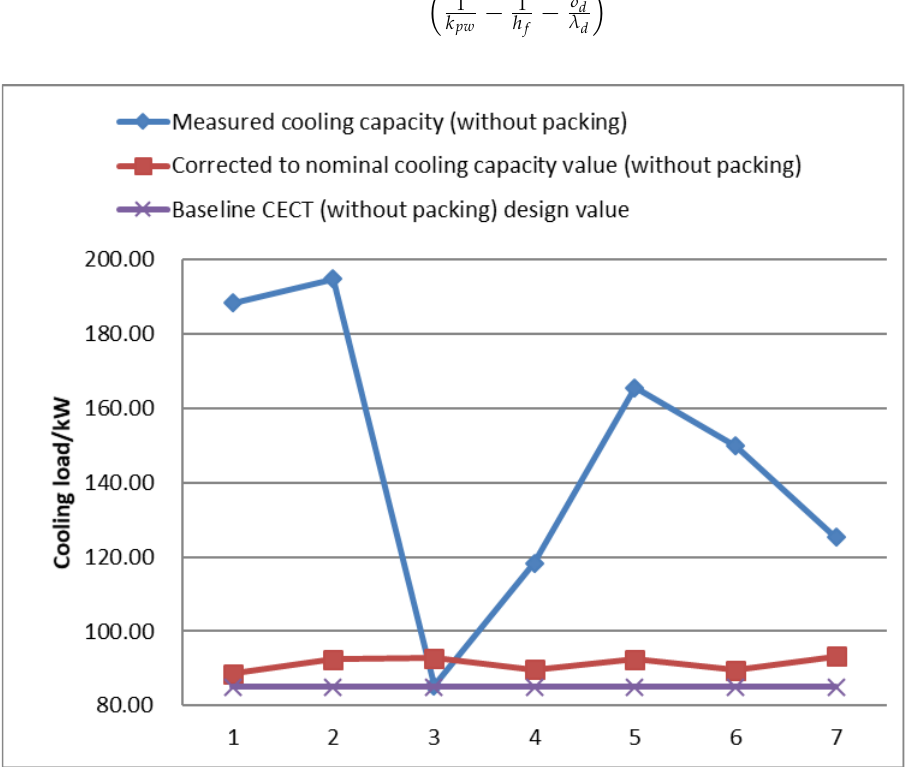
Figure 6. Comparison of cooling loads under different operating conditions.